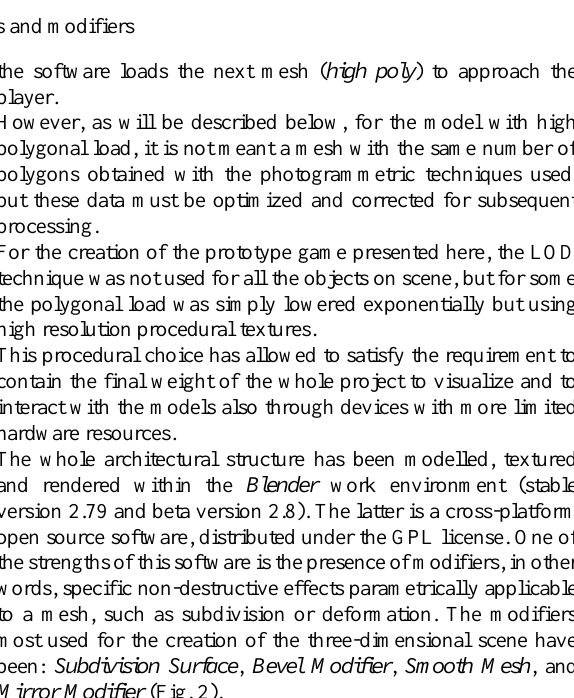
Figure 2. Game environment design using Blender 3D sculpture tools and